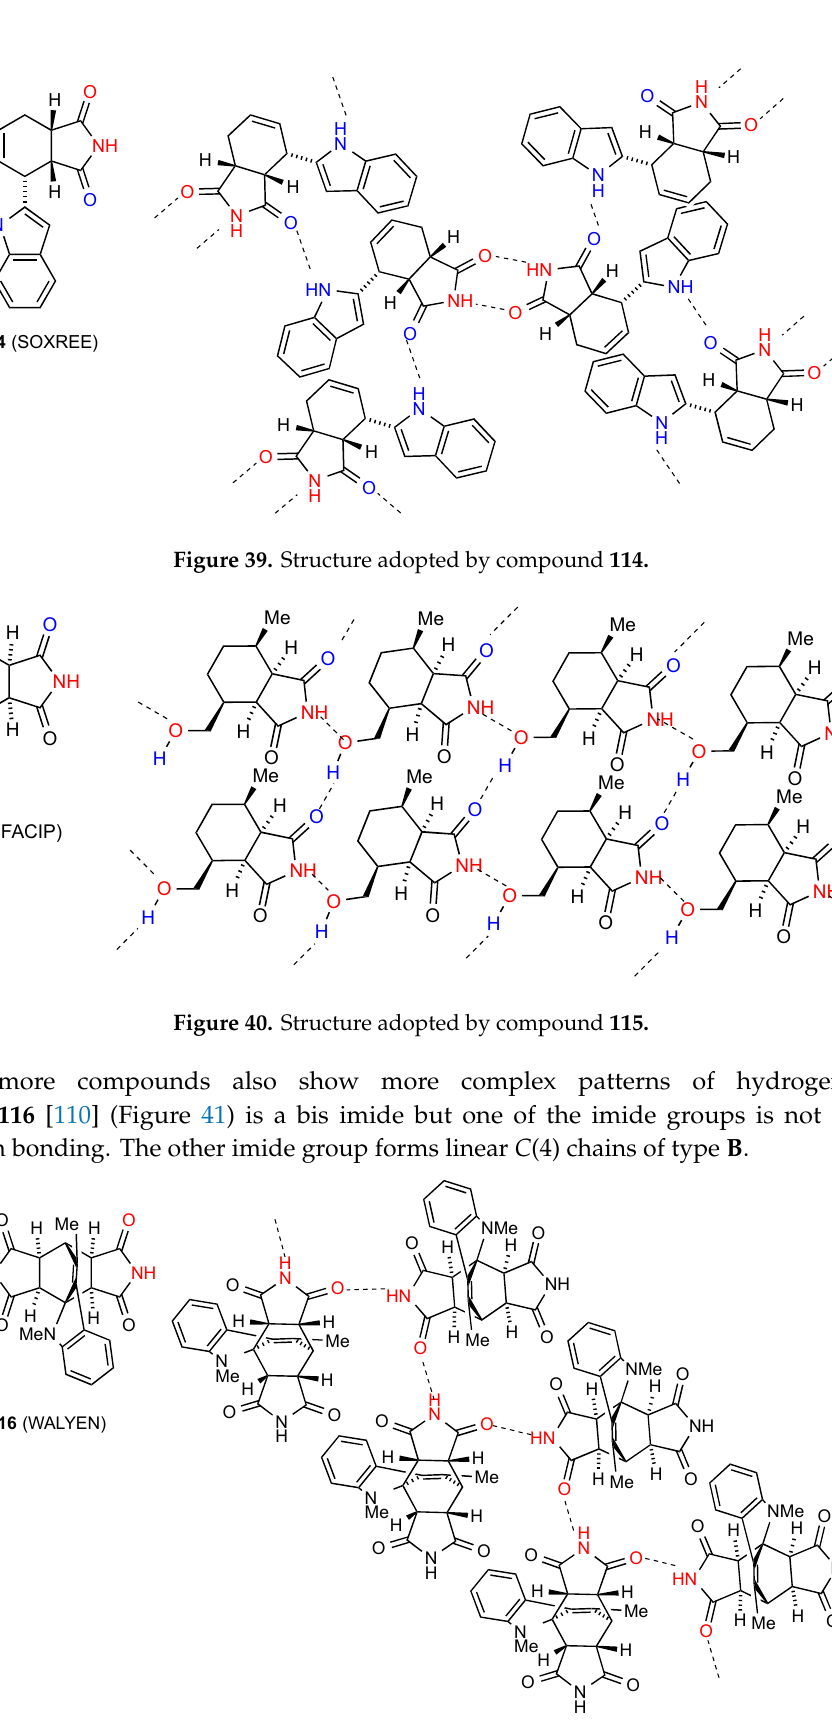
Figure 41. Structure adopted by compound 116.